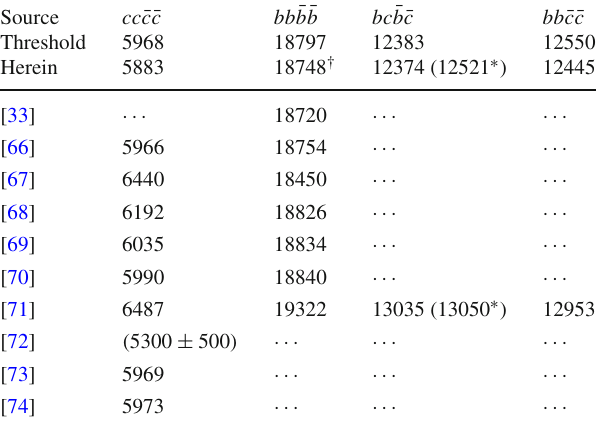
Table 2 Row 1: experimental meson-meson thresholds. They are 2 η c , 2 η Row 2: our computed results for the masses of J = 0 ++ ground-state tetraquark systems. For comparison, the other rows list values obtained elsewhere. Masses are in MeV. All entries describe av–av configura- tions, except those marked by an asterisk, which are sc–sc. The entry highlighted by † was obtained previously